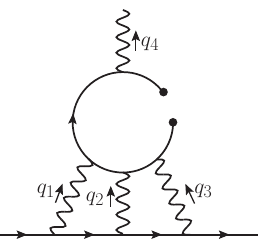
Figure 1. HLbL contribution to g-2. Figure 2. Quark condensate contribution to HLbL. In the static q 4 the left